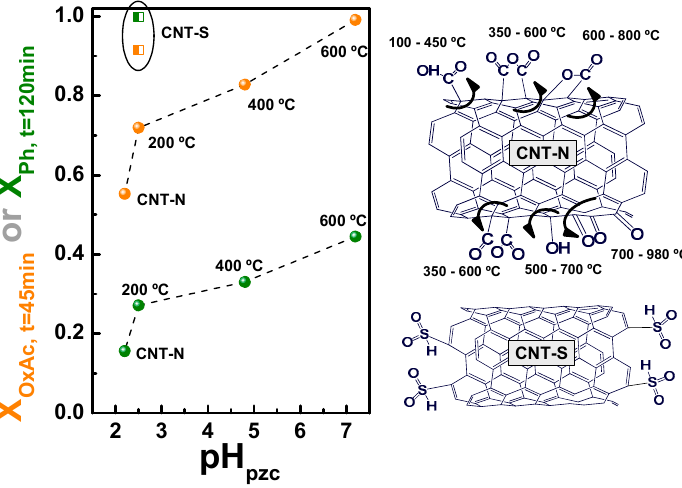
Figure 8. Influence of the surface chemistry on the catalytic performance of CNT: oxalic acid and phenol conversions obtained after 45 and 120 min of reaction, respectively, plotted against the pH pzc of nitric acid and thermally treated samples and sulfuric treated samples. Reprinted from reference [38] with permission from Elsevier.